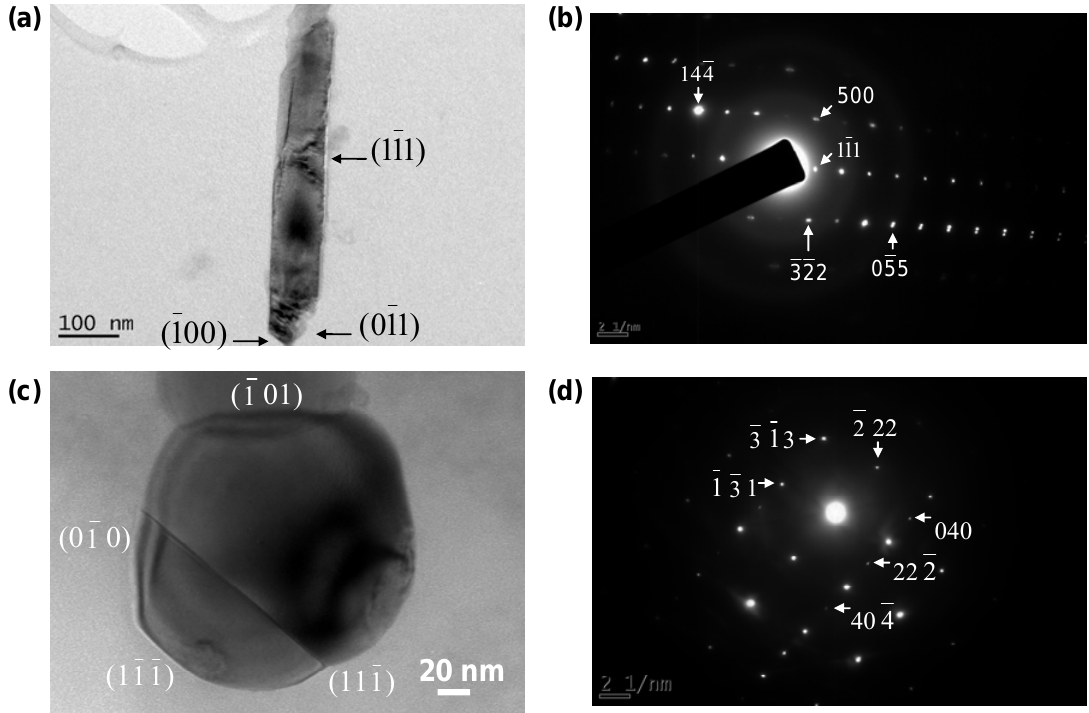
Figure 4. TEM images and diffraction patterns of mefenamic acid nanocrystals grown from the microemulsions. ( a ) Form I nanocrystal grown after 1 day from the 95 mg/mL mefenamic acid in DMF microemulsion at 8  C. ( b ) Diffraction pattern of (a) showing that the crystal is nearly aligned along the [011] zone axis. ( c ) Form II nanocrystal grown after 1 day from the percolating 70% AOT 80 mg/mL mefenamic acid in DMF microemulsion at 8  C. ( d ) Diffraction pattern of (c) showing that the crystal is nearly aligned along